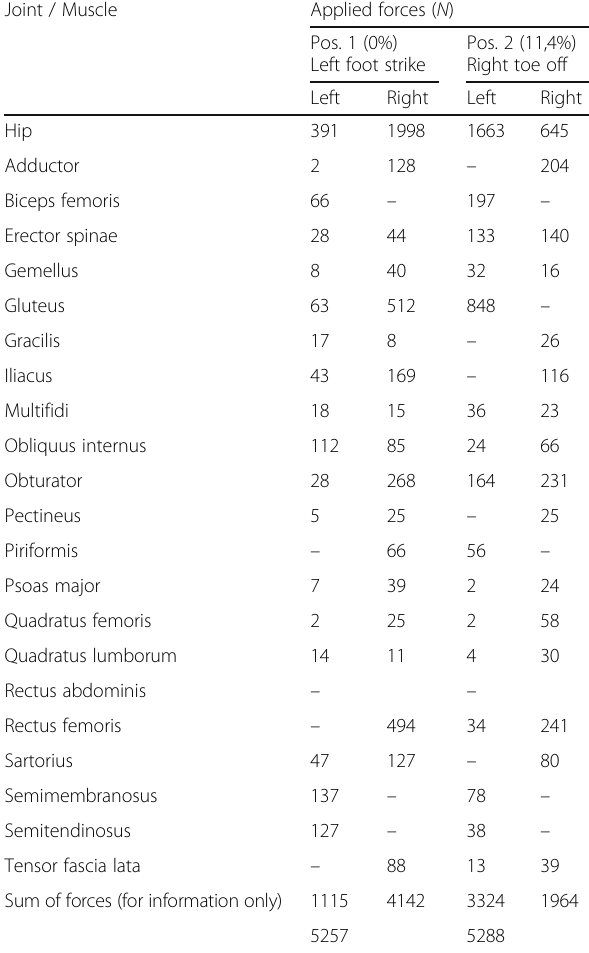
Table 2 Applied forces (N) in position 1 and position 2 Joint / Muscle Applied forces ( N